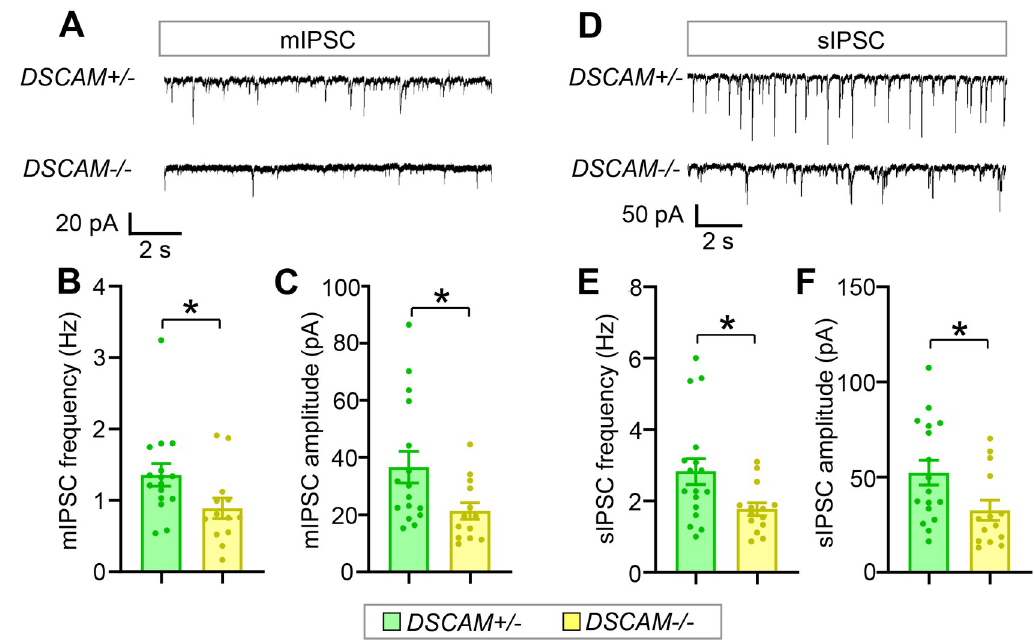
Fig 6. Loss of DSCAM impairs GABAergic synaptic transmission to neocortical PyNs. ( A ) Representative traces of mIPSCs from PyNs in layer II/III of the ACC in DSCAM +/ − and DSCAM − / − brain slices. ( B, C ) Quantification of mIPSC frequency ( B ) and amplitude ( C ). For each mouse, 3–5 PyNs were recorded. A total of 5 DSCAM +/ − and 4 DSCAM − / − mice were analyzed. N: 16 for DSCAM +/ − , and 13 for DSCAM − / − . ( D ) Representative traces of sIPSCs from PyNs in layer II/III of ACC in DSCAM +/ − and DSCAM − / − brain slices. ( E, F ) Quantification of sIPSC frequency ( E ) and amplitude ( F ). Approximately 3–5 PyNs were recorded for each mouse. A total of 5 DSCAM +/ − and 4 DSCAM − / − mice were analyzed. N: 17 for DSCAM +/ − , 14 for DSCAM − / − . Student t test. * : p < 0.05. The data underlying this Figure can be found in https://doi.org/10.5281/zenodo.7714234. ACC, anterior cingulate cortex; DSCAM, Down syndrome cell adhesion molecule; mIPSC, miniature inhibitory postsynaptic current; PyN, pyramidal neuron; sIPSC, spontaneous inhibitory postsynaptic